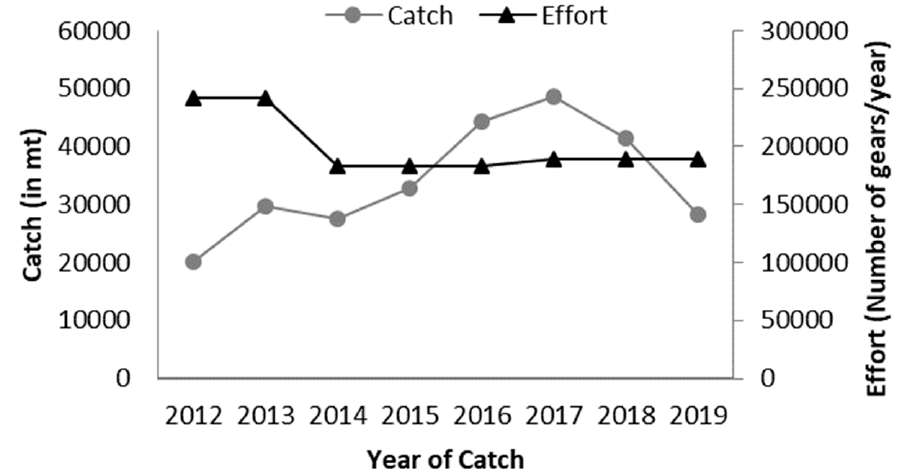
Figure 1. Catch effort data of sardine in the BoB, Bangladesh.